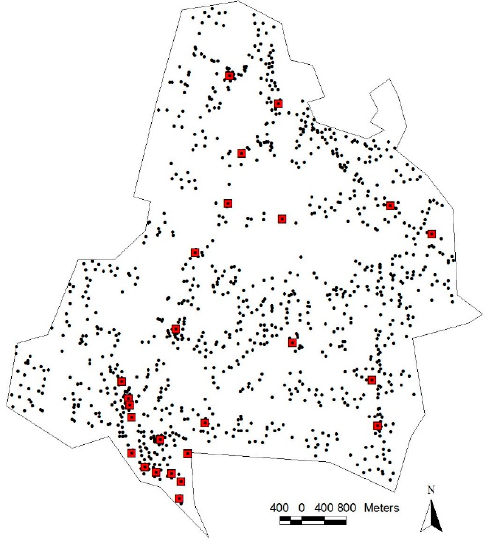
Figure 2. Survey subject locations. Note: Points represent survey subject locations, and square areas indicate the tourism sites.